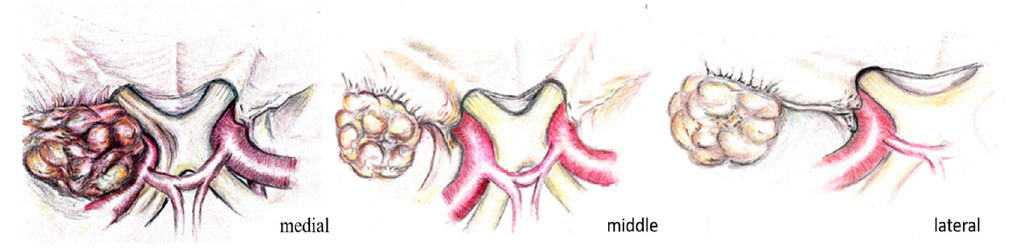
Figure 1. Meningiomas: localization along the sphenoid ridge.